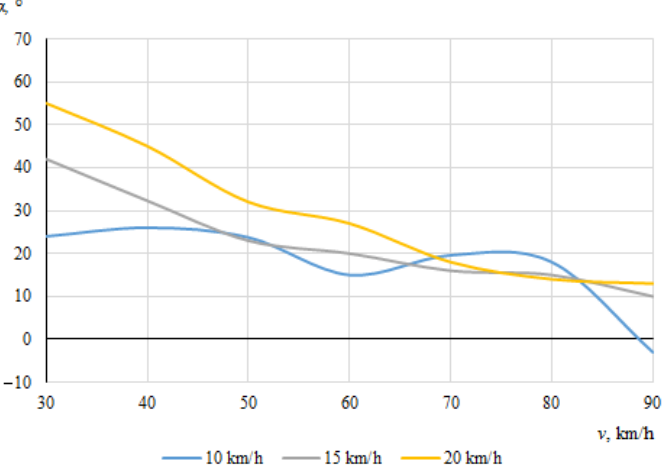
Figure 21. Cyclist throwing angle (impact angle 90°).